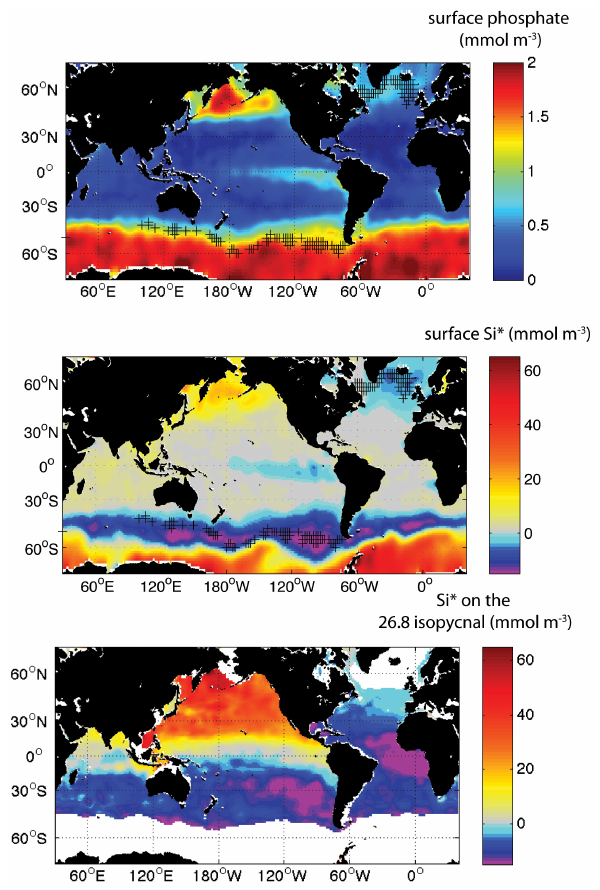
Fig. 1. Global nutrients at the ocean’s surface and in the SAMW layer. (a) Surface phosphate from WOA01 (Conkright et al., 2001). (b) Surface Surface Si ∗ = Si(OH) 4 -NO − from WOA01. (c) Si ∗ on 3 the 26.8 isopycnal, at the center of the SAMW layer. In panels (a) and (b), black hatches indicate regions between 65 ◦ S and 65 ◦ N where annual maximum mixed layer depths exceed 400m, where mixed layer depths are taken from de Boyer Mont´egut et al. (2004). Panel (c) is recreated after Sarmiento et al. (2004). The white area represents the region where the annual mean surface density ex- ceeds 1026.8kgm −